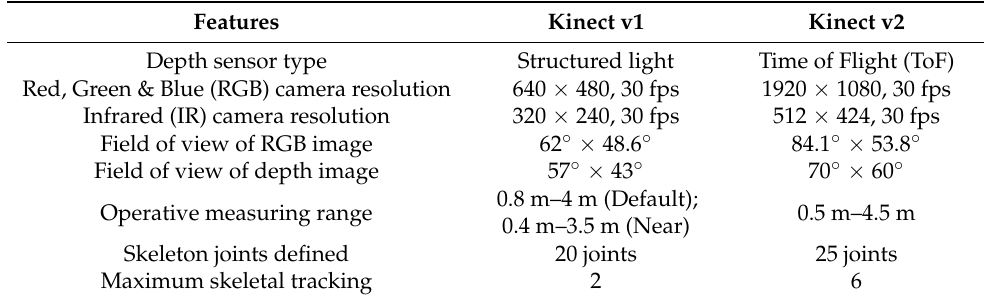
Table 1. Comparative specifications of Microsoft Kinect v1 and v2.